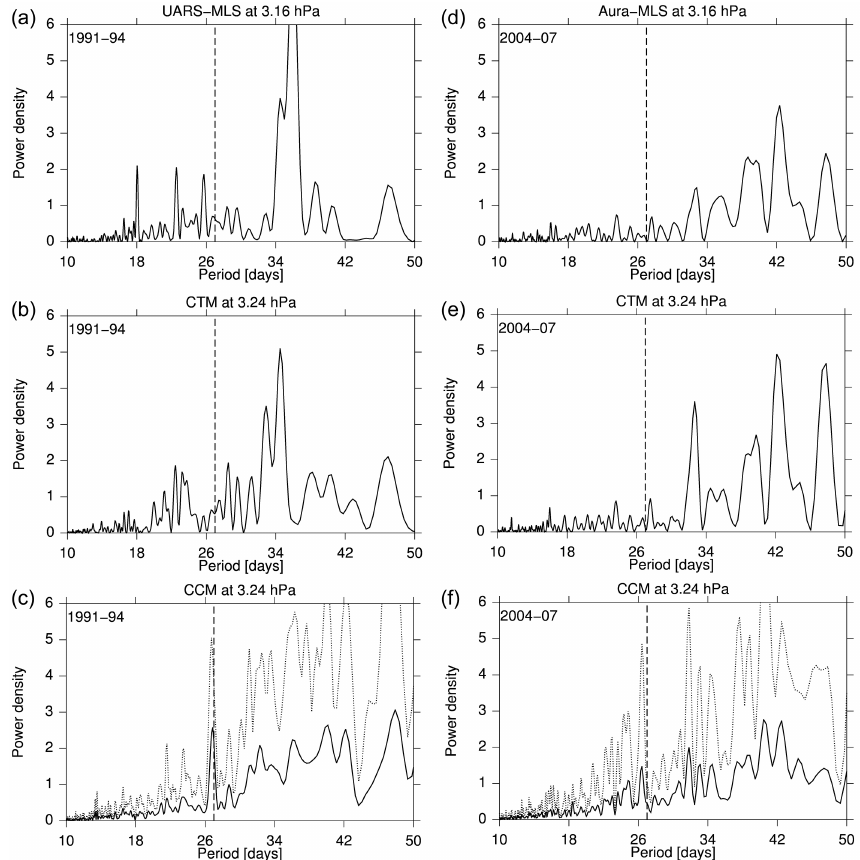
Figure 3. Ozone Lomb–Scargle periodograms for (a, b, c) 1991–1994 and (d, e, f) 2004–2007 periods. The top panels represent ozone Lomb– Scargle periodograms from (a) UARS MLS and (d) Aura MLS observations. The middle panels (b, e) represent the ozone Lomb–Scargle periodograms for CTM simulation and the bottom panels (c, f) the average periodogram of the CCM ensemble. The dotted envelope (c, f) indicates the 2 σ standard deviation of the ensemble of CCM